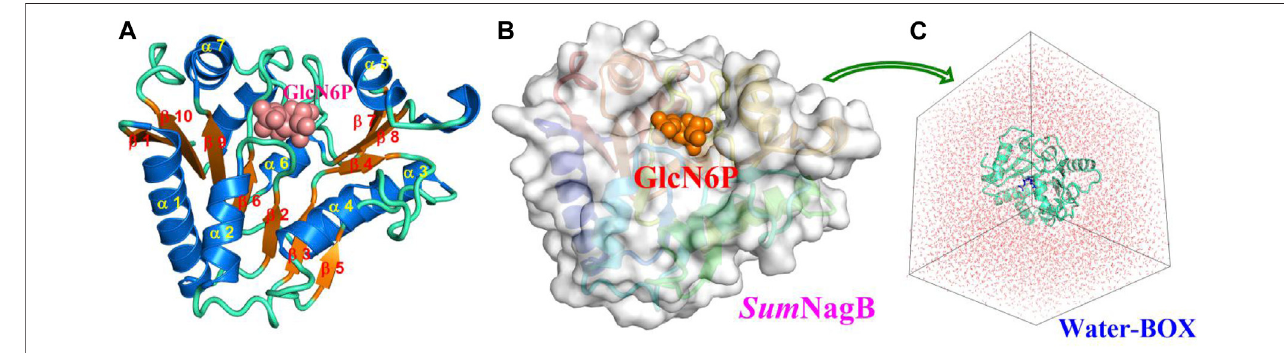
FIGURE 2 | Crystal structure (A) and the corresponding surface model (B) of Smu NagB with GlcN6P in addition to the initial model from MM MD simulations (C) . Helices are blue and numbered α 1 to α 7; β -strands are orange and numbered β 1 to β 10. GlcN6P is shown as a